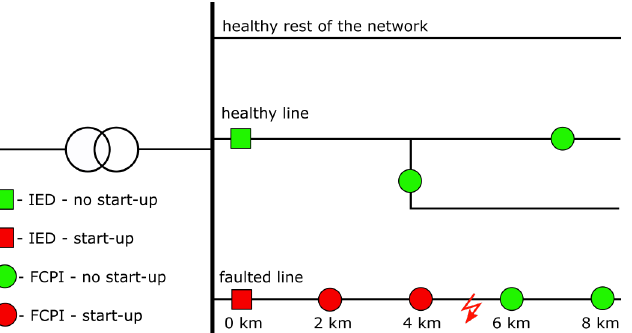
Figure 1. The idea of decentralized localization of a fault location in an MV network using FCPI as an